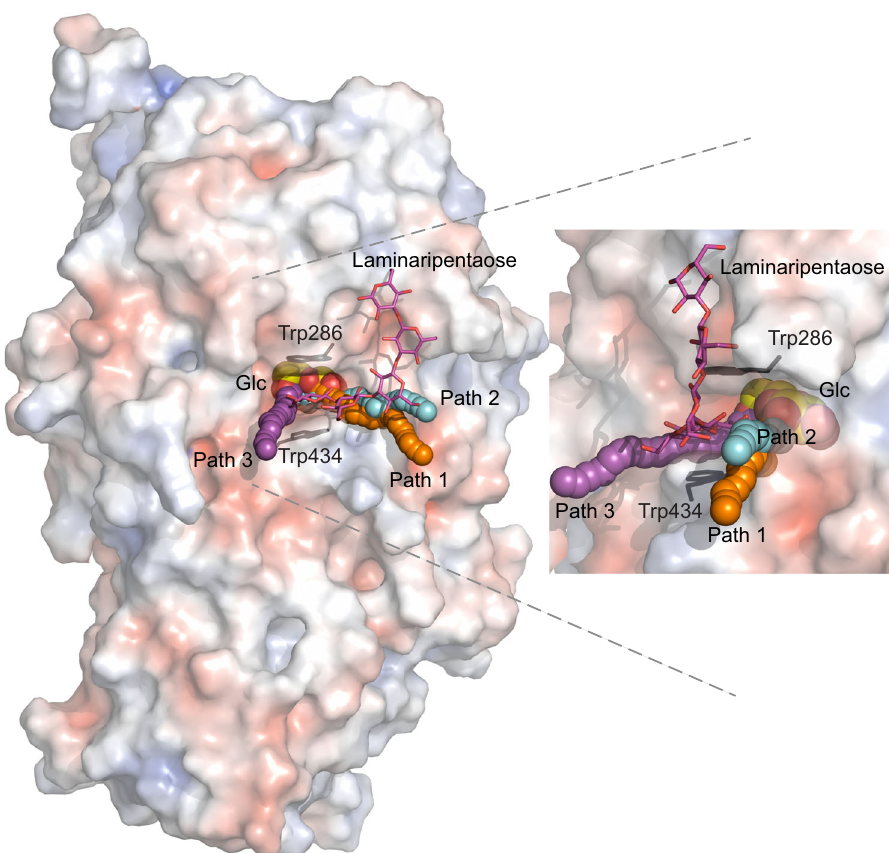
Fig.8|Glcegresspaths1-3,illustratedonthetopofWTHvExoIwithboundGlc (carbonsincpkyellowlines,andspheres)andlaminaripentaose(cpkmagenta sticks). Path1(WTandW434H),path2(W434A),andpath3(vertical)aredepicted inorange,cyan,andmagentaspheres,respectively,andalignednexttoeachother. Path 3 is found when no ligand is bound at the +1 and +2 subsites. Illustrated trajectories represent frames that correspond to consecutive stages of Glc